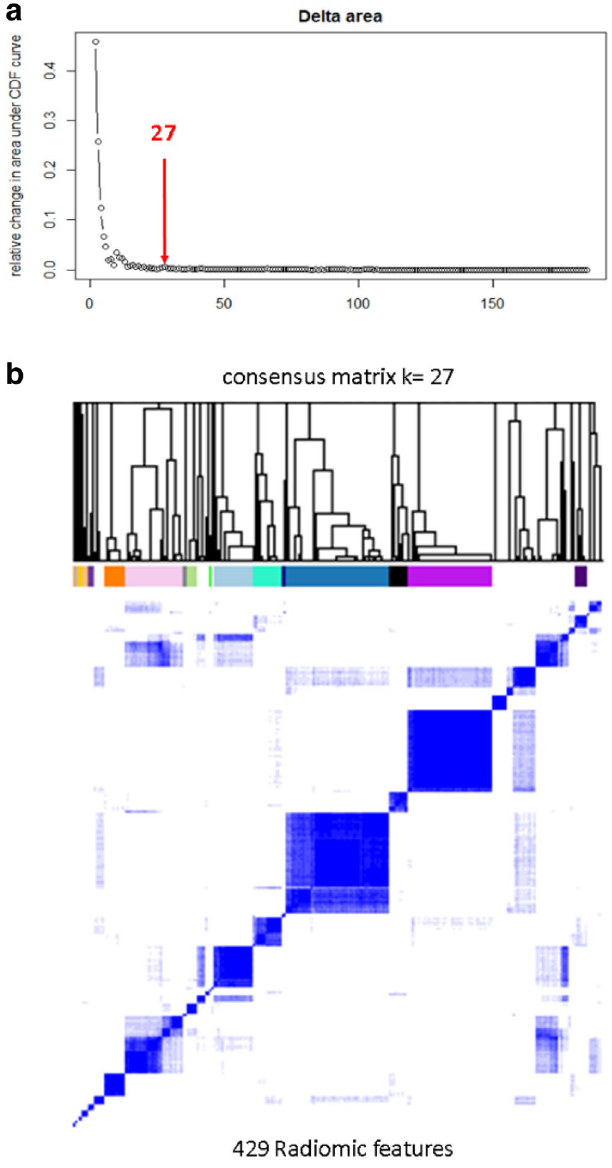
Figure 2. Selection of derived radiomic features. Cumulative distribution function (CDF) and consensus clustering are used to determine the optimum number of clusters of radiomic features. The red arrow in ( a ) represents the point ( k = 27) where the relative change in CDF drops below 10%; ( b ) shows the clustered dendrogram corresponding to the 27 derived